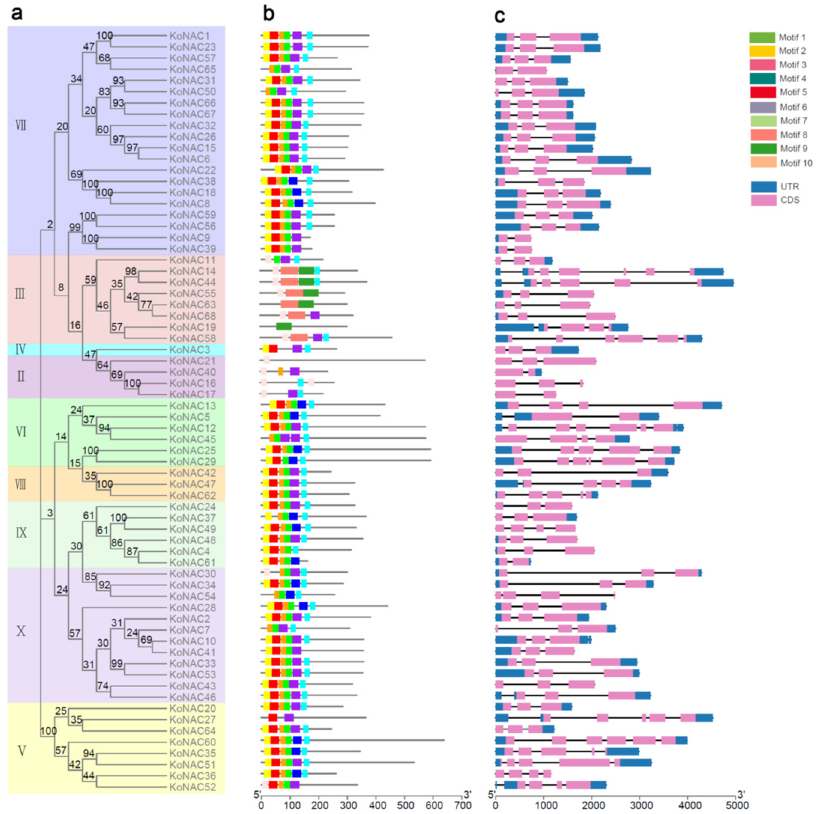
Figure 4. Gene structure and motif organization of the Ko NAC genes. ( a ) The unrooted NJ tree of Ko NAC proteins was constructed using MEGA 7.0, while different classes were represented in different colors. Bootstrap values from 1000 replicates are shown on the nodes. ( b ) Ten different conserved motifs of Ko NAC proteins were identified using MEME software. Different colored boxes indicate different motifs. ( c ) The structures of Ko NAC genes are shown, including UTR regions (blue box), exons (grey boxes), and introns (black lines). UTR, untranslated region; CDS, coding sequence of a gene.